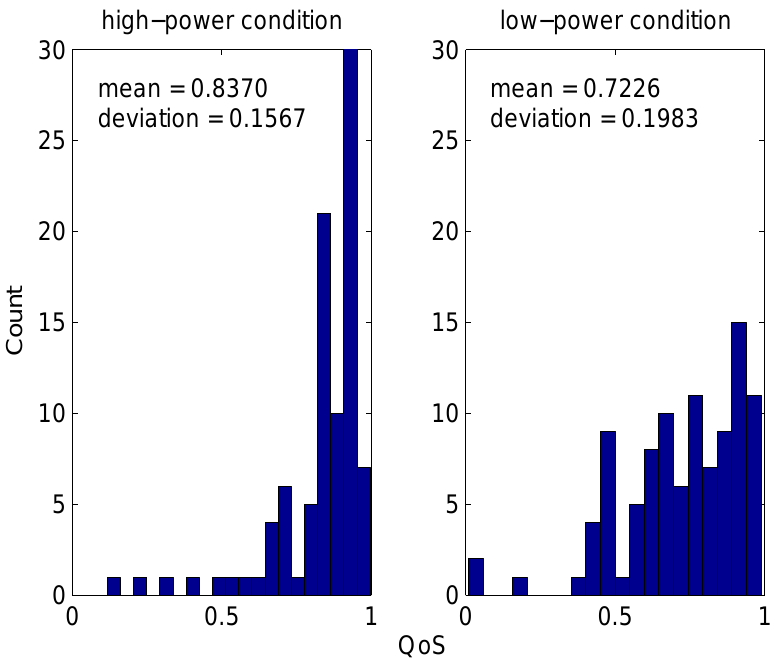
Figure 20. Histogram of the QoS performance under the energy-efficiency-oriented policy for ( left ) high and ( right ) low power storage